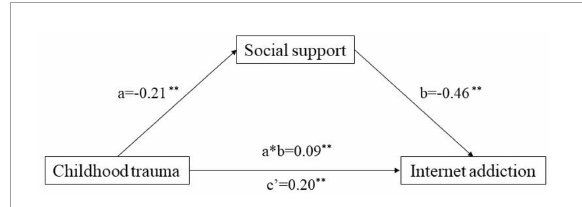
FIGURE1 The mediating effect of social support on childhood trauma and Internet addiction (a*b, indirect effect; c, total effect; c’, direct effect; ** p <